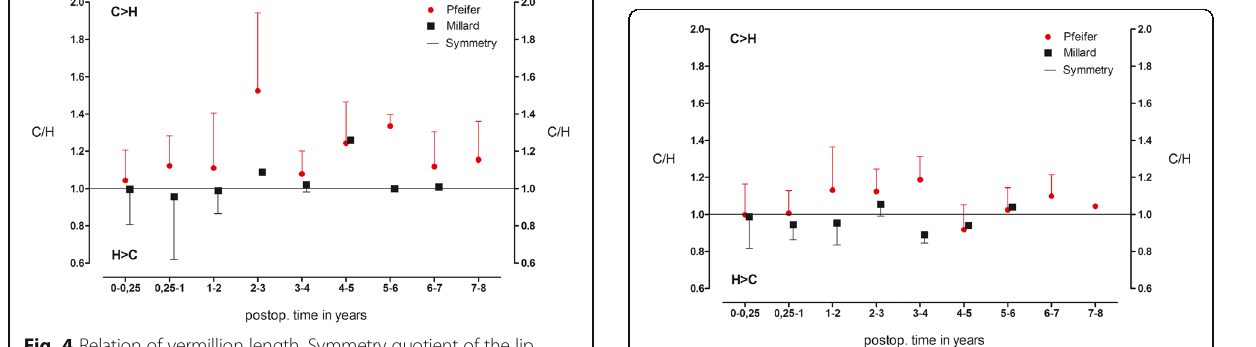
Fig. 4 Relation of vermillion length. Symmetry quotient of the lip vermillion length over the entire follow-up period in the Millard group ( n =36) compared to the Pfeifer group ( n =44) ( p =0.003). Presented as the means±standard deviation (SD)